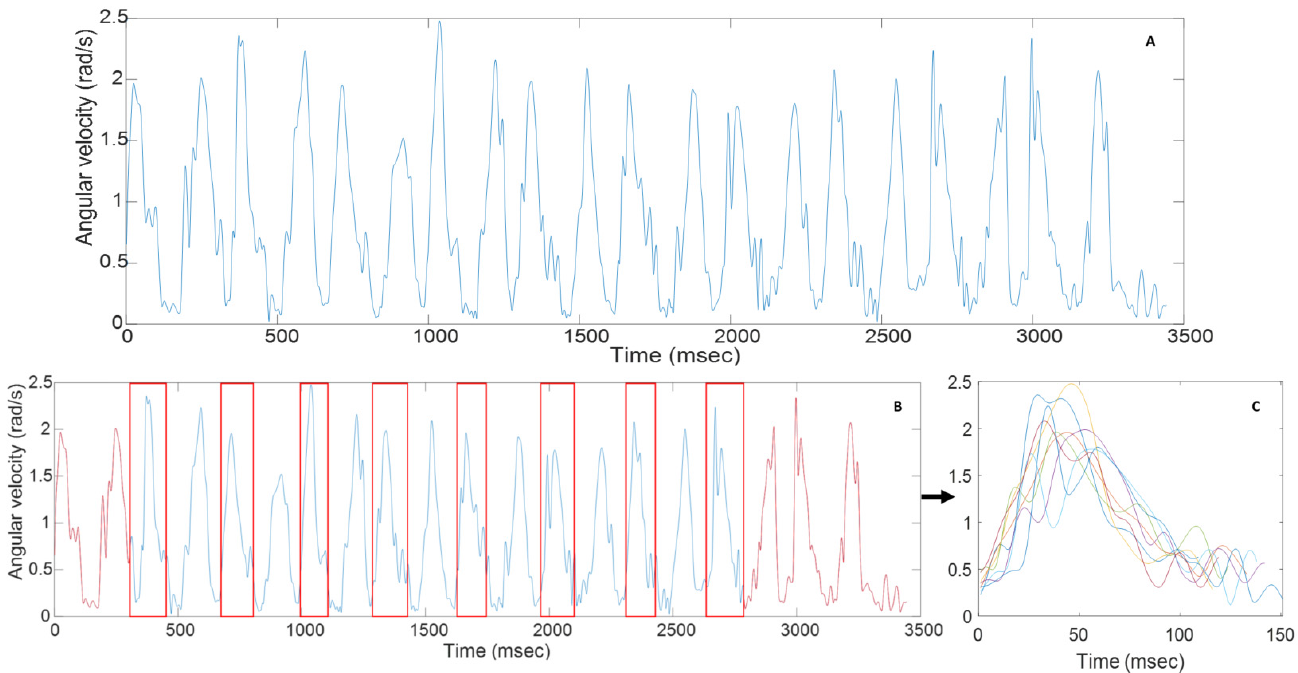
Figure 1. Full-length angular velocity signal ( A ), timings of separate repetitions with the first and last repetition in red ( B ), and an example of the eight segmented repetitions (red boxes) of a reach-forward task ( C ).